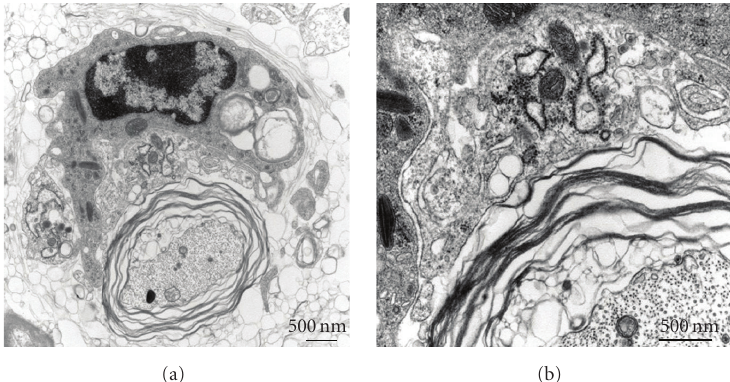
Figure 15: Macrophage-mediated myelin stripping in DM-induced demyelinating plaque. (a) A macrophage (upper portion of the figure) is observed surrounding an intact axon (lower portion of the figure) with uncompacted myelin. Myelin figures are observed within the cytoplasm of this macrophage indicative of prior engulfment of myelin. (b) Higher magnification demonstrates close apposition of the macrophage cell membrane and an outer layer of uncompacted myelin. The axoplasm and axolemma are intact and the adjacent myelin shows vesiculation indicative of myelin degeneration. Original magnification for (a) is 15,000x and for (b) is 40,000x. (adapted from the work of